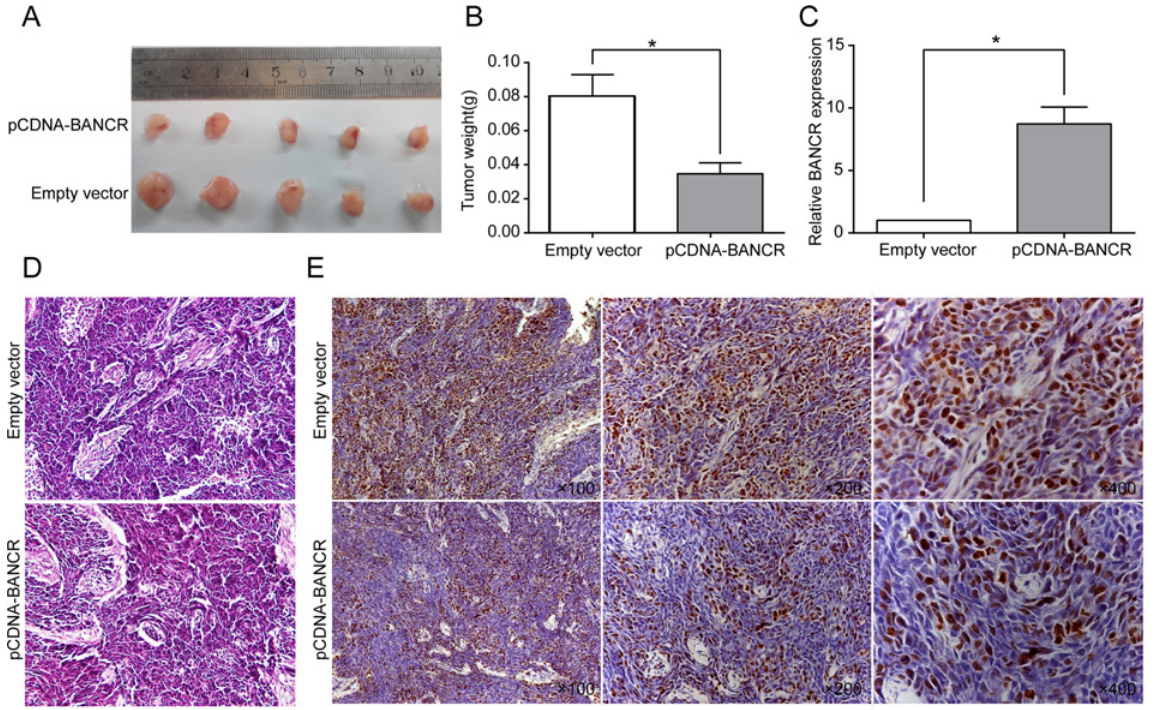
Fig 4. BANCR inhibits tumor growth in a xenograft mouse model. (A) Total number of tumors after removal from the mice. (B) Tumor weight when the tumors were harvested. The data represent the mean ± SD. * , P < 0.05. (C) qRT-PCR analyses indicated that BANCR expression was significantly increased in vivo. The data represent the mean ± SD. * , P < 0.05. (D, E) Representative images of HE staining and immunohistochemistry of the tumor. The IHC showed an upregulation of BANCR and a decreased expression of the proliferation index